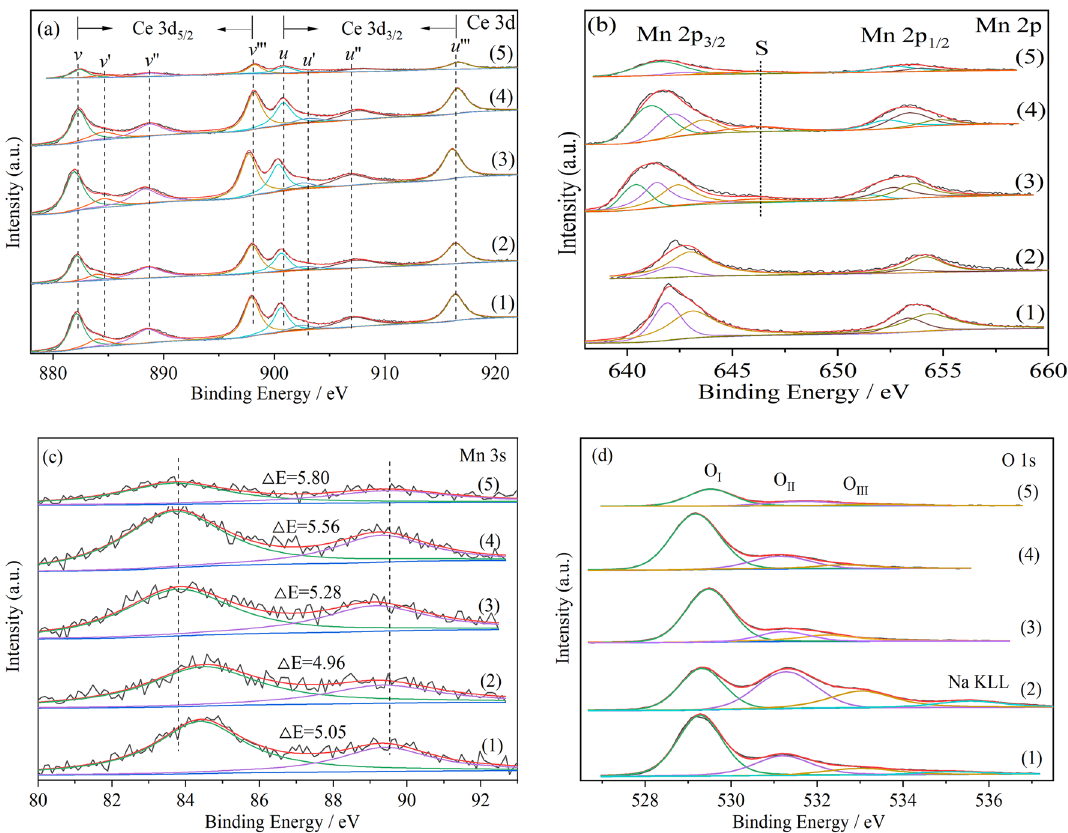
Figure 7. XPS spectra of all cerium manganese catalysts: ( a ) Ce 3d; ( b ) Mn 2p; ( c ) Mn 3s; ( d ) O1s. (1) CM-Na; (2) CM-NaC; (3) CM-NC; (4) CM-N; (5)